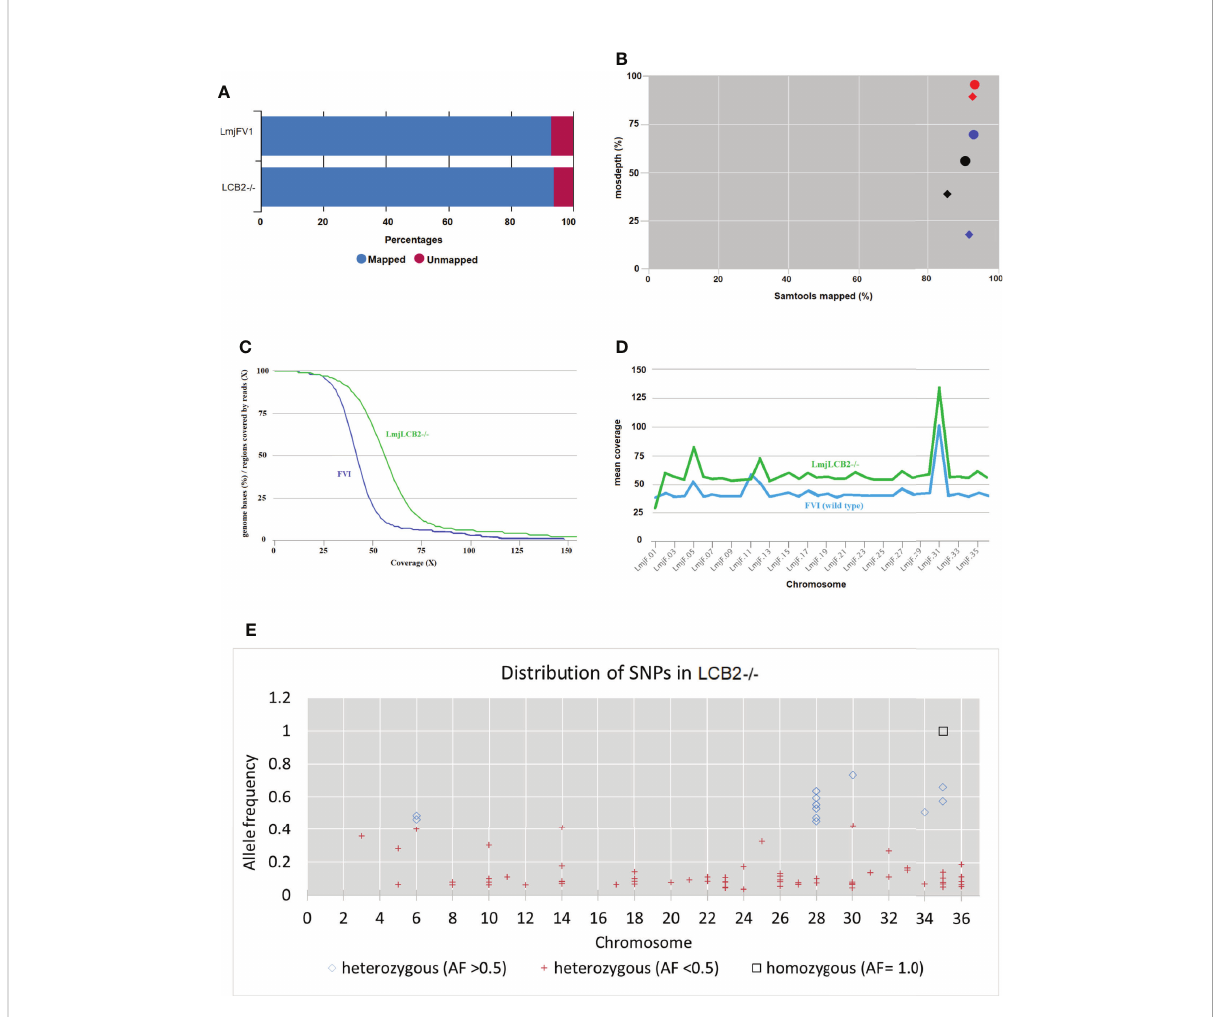
FIGURE 1 WGS Samtools parameters in FVI (wild type) and Lmj LCB2-/-. (A) Bar chart showing mapped and unmapped alignment scores (%) in both LmjLCB2-/- and FVI. (B) Scatterplot showing the correlation between mapped reads (%) ( x -axis) and coverage (%) ( y -axis). Data shows the median coverage (black), and the fraction of the genome with at least ≥ 30x (red) and ≥ 50x (blue) coverage as estimated with mosdepth (performs coverage depth for WGS, exome, or targeted sequencing) in Lmj LCB2-/- (circles) and wild type (FVI) (diamonds). (C) Distribution of coverage depth with the number of locations in the reference genome with a given depth of coverage. (D) Mosdepth average coverage per contig or chromosome in FVI and Lmj LCB2-/-. (E) Distribution of homozygous and heterozygous SNPs in LmjLCB2-/- (not present in the parental wild type) based on their allele frequency (Pedersen and Quinlan, 2018). See Materials and Methods and S1 and S2 Tables for full